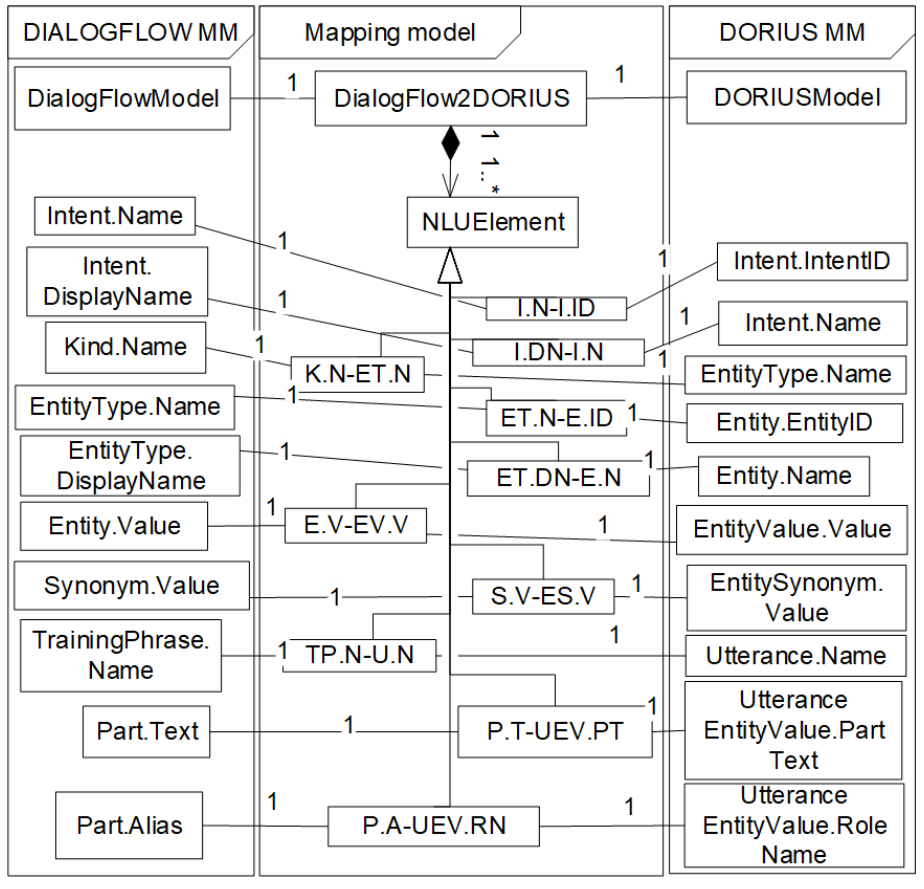
Figure 6. Dialogflow—DORIUS Mapping